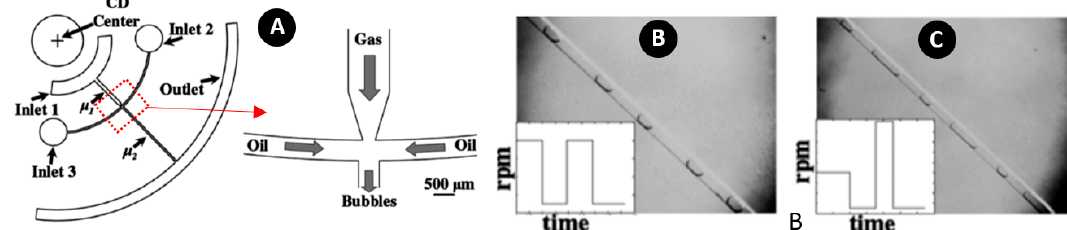
Figure 15. ( A ) Gas-bubble formation configuration; ( B , C ) Bubble generation by changing rotational speed to form various sizes with different intervals. Reprinted with permission from [127].